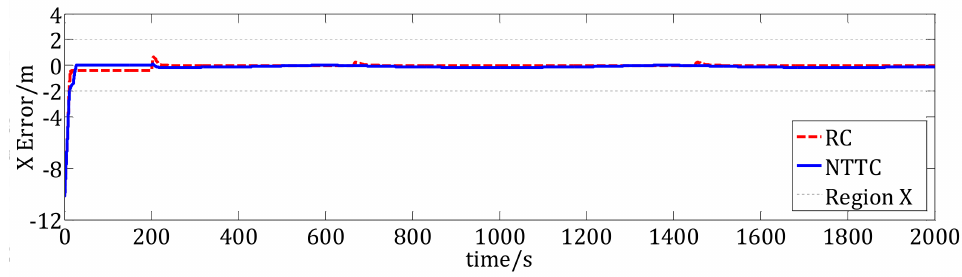
Figure 7. Position tracking errors in X direction.